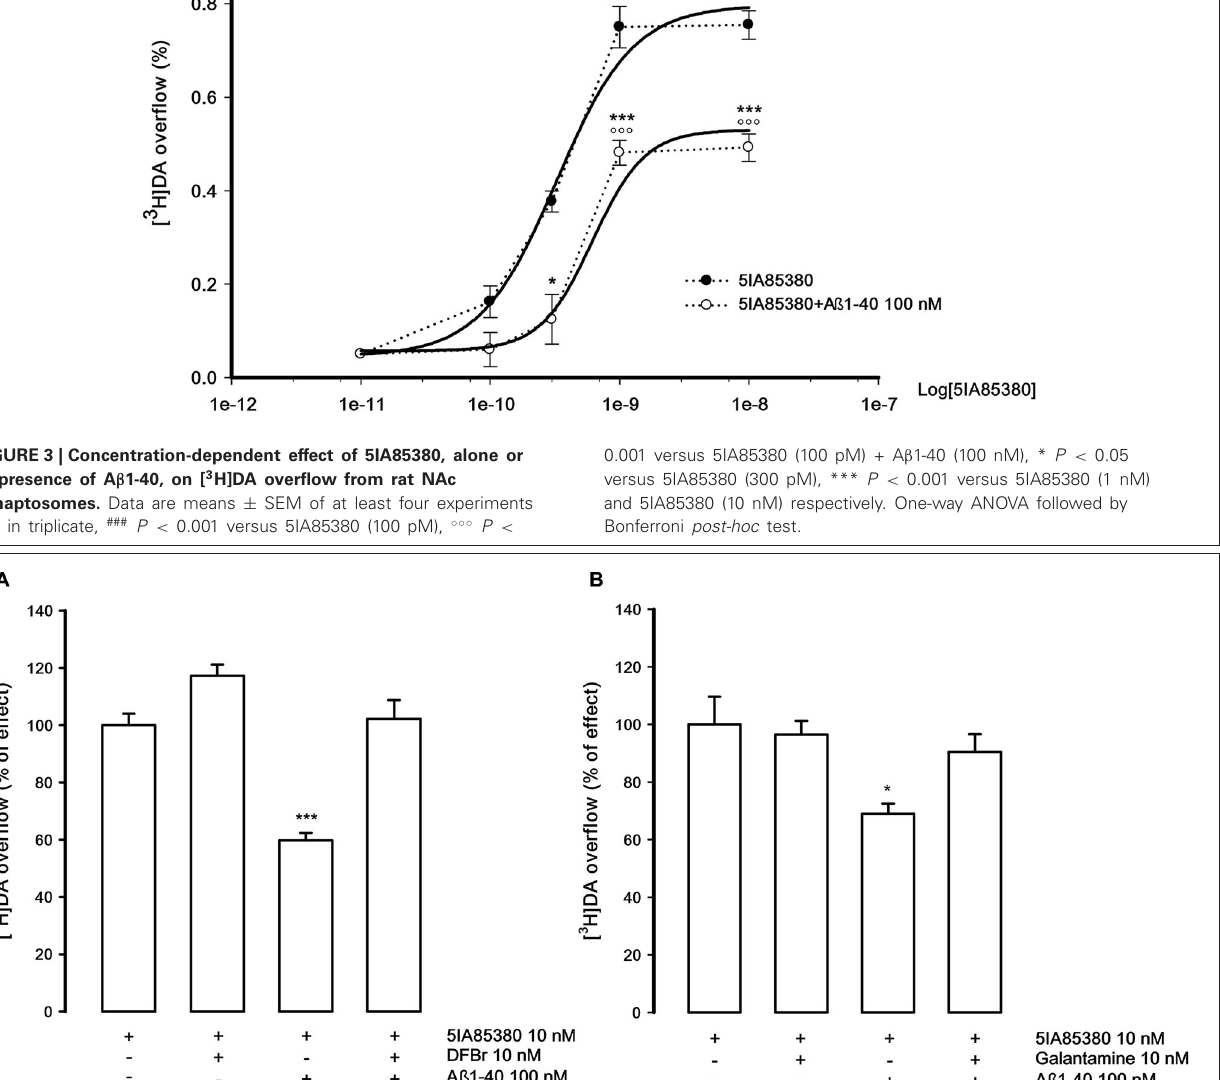
Effect of galantamine on the inhibition by A β 1-40 of 5IA85380-evoked [ 3 H]DA overflow from rat NAc synaptosomes. Data are means ± SEM of four experiments run in triplicate, * P < 0.05 versus 5IA85380. One-way ANOVA followed by Bonferroni post-hoc